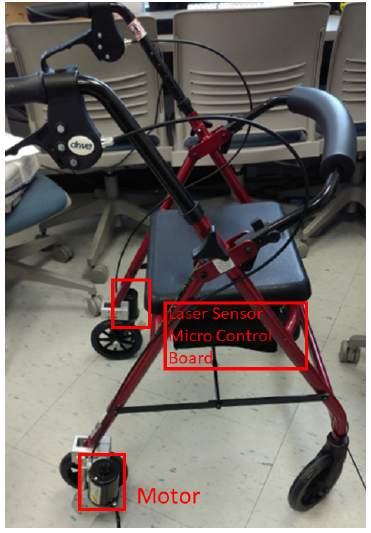
Figure 2. The motorized walker with speed control, preset course navigation, and obstacle avoidance. Table 2. Speed settings for trials with the motorized